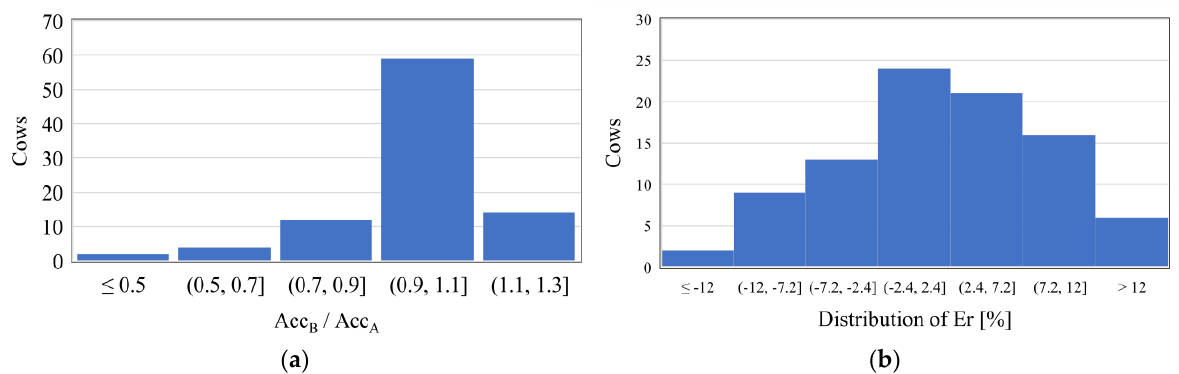
Figure 10. Performance indicators for scenario B. ( a ) Histogram distribution of the ratio between the average accuracy obtained in scenarios B and A for the same cow; ( b ) distribution of the error Er on the sum of the daily yields over the test days.